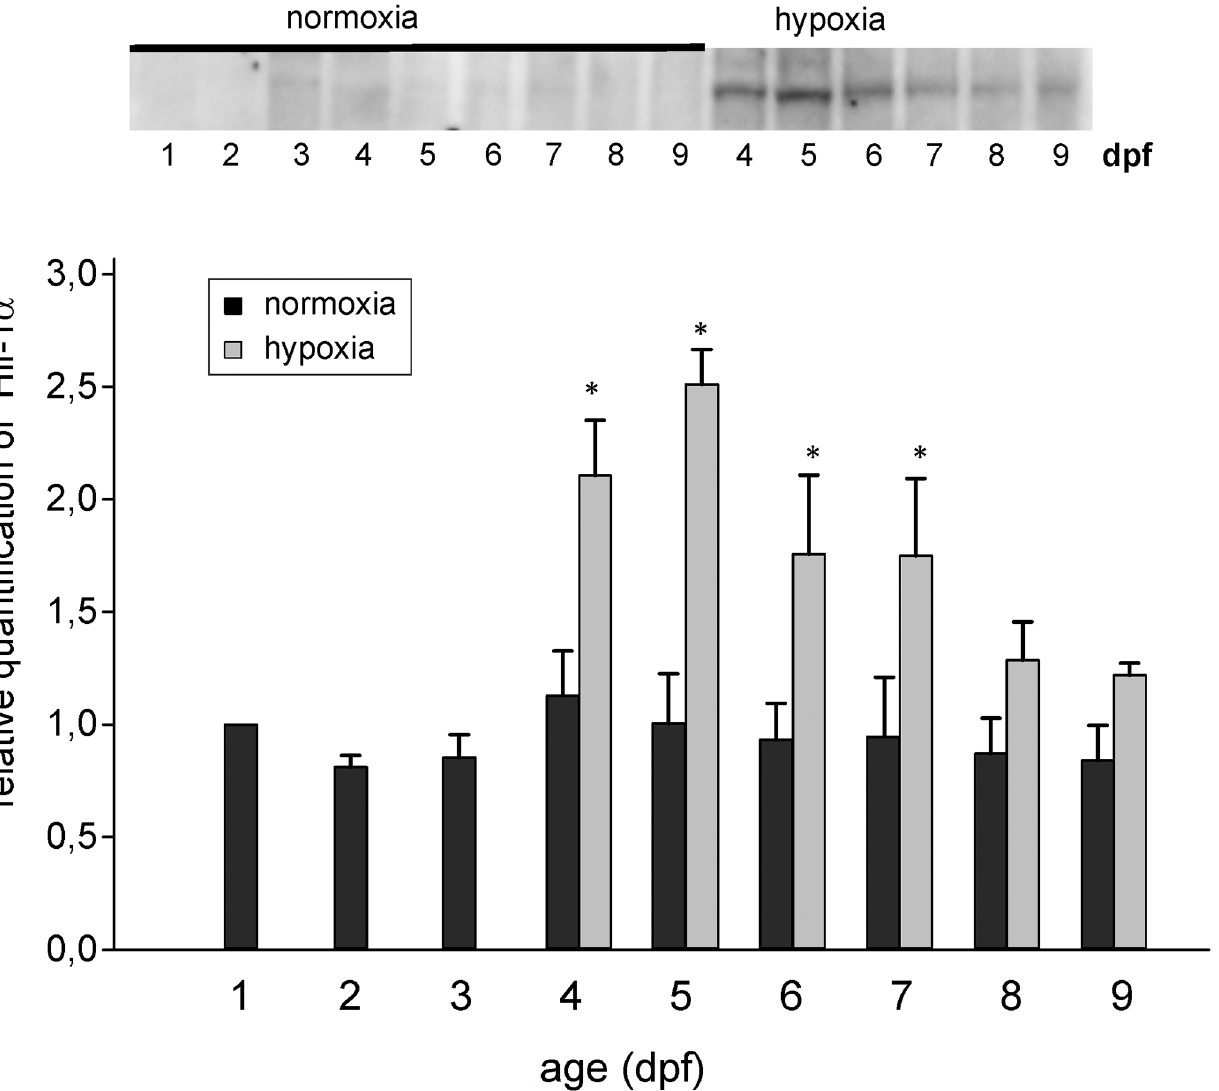
Fig 2. Western blot and relative quantification of total zebrafish protein between 1 and 9 dpf under normoxic conditions, and of larvae incubated under hypoxic conditions (PO 2 = 5 kPa) starting at 3 dpf tested with the zfHif-1 α specific antibody. * indicate significant differences between hypoxic and normoxic samples (p < 0.05, n =